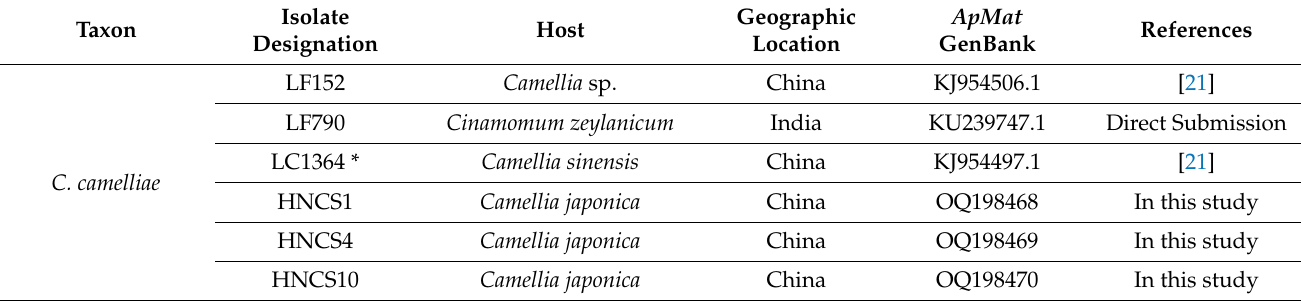
Table 1. GenBank accession numbers of nucleotide sequences used in this